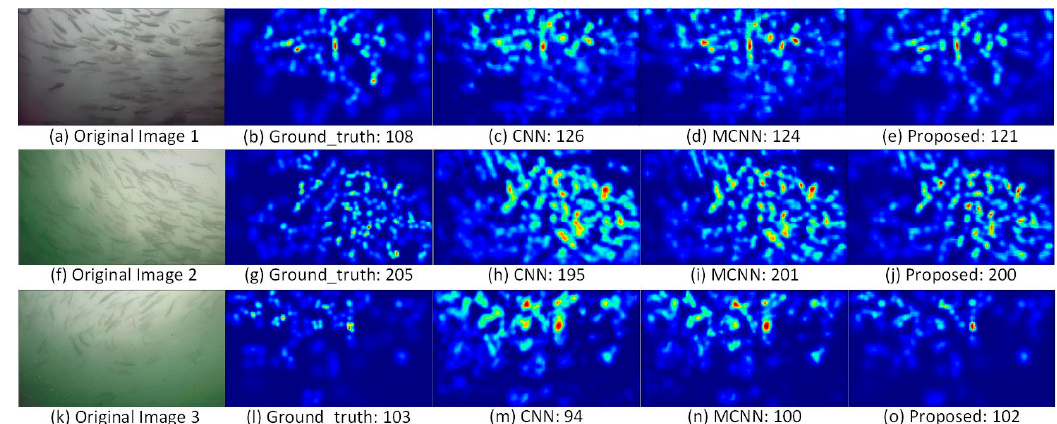
Figure 13. Test results of different models. ( a , f , k ) are original images; ( b , g , l ) are the ground truth density maps corresponding to ( a , f , k ) respectively; ( c , h , m ) are the estimated density maps generated by CNN corresponding to ( a , f , k ) respectively; ( d , i , n ) are the estimated density maps generated by MCNN corresponding to ( a , f , k ) respectively; ( e , j , o ) are estimated density maps generated by the proposed model corresponding to ( a , f , k ) respectively.